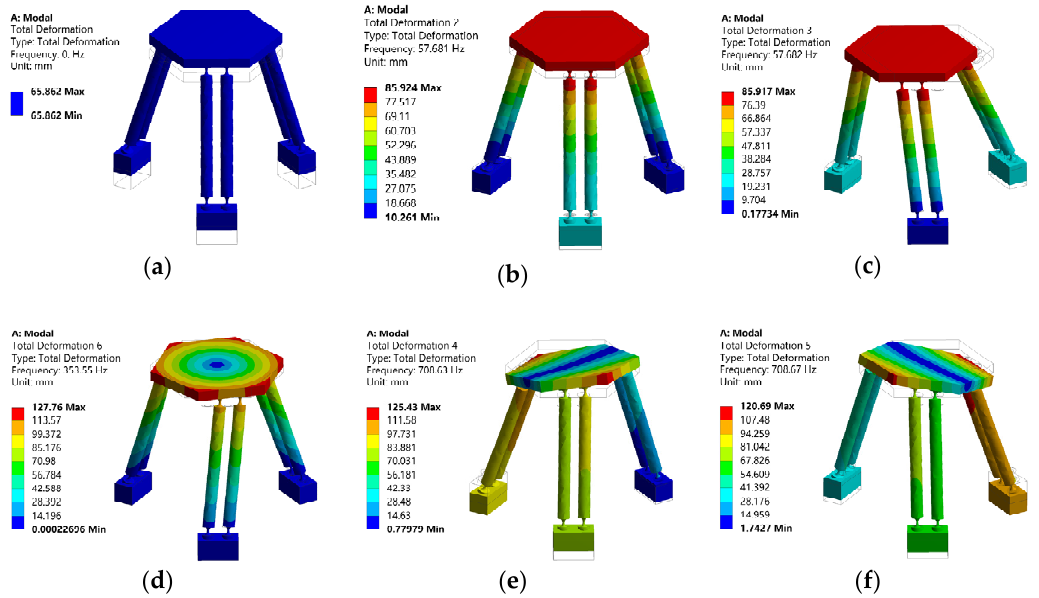
Figure 4. The first six modal shapes of the micro-manipulator. ( a ) Modal shape 1. ( b ) Modal shape 2. ( c ) Modal shape 3. ( d ) Modal shape 4. ( e ) Modal shape 5. ( f ) Modal shape 6.